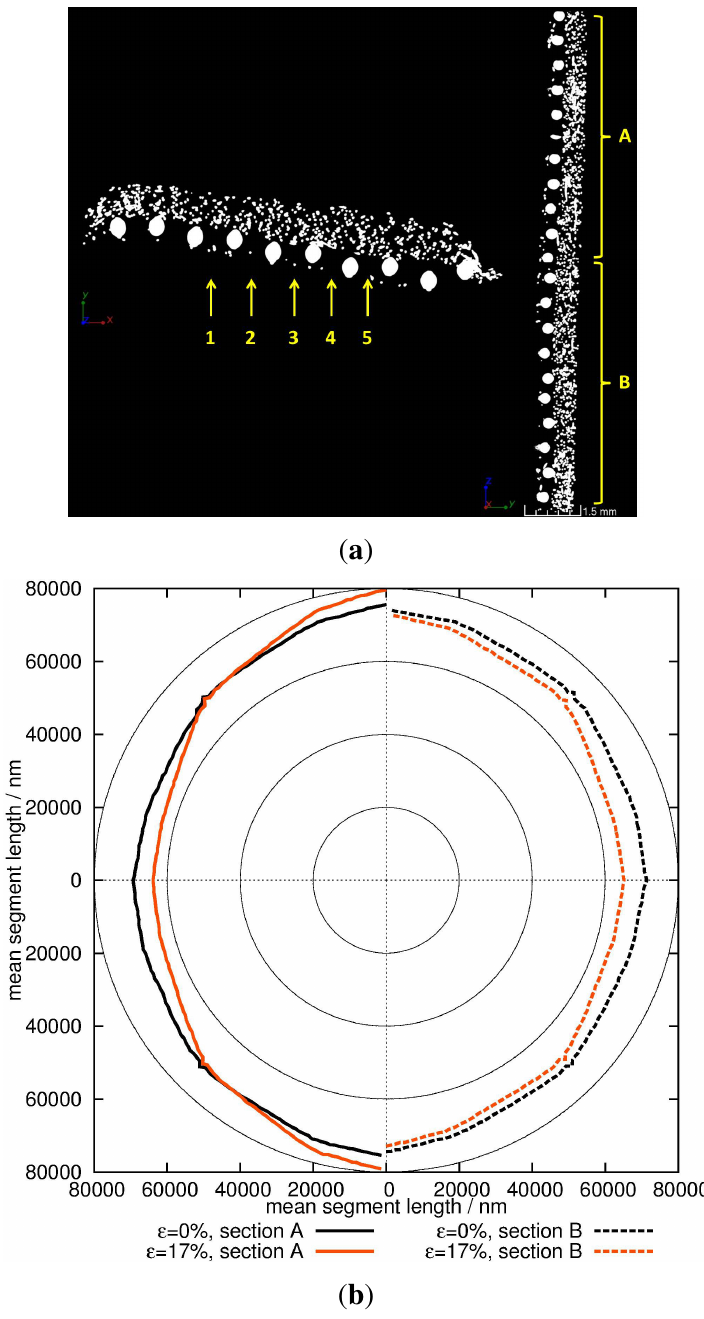
Figure 6. ( a ) extracted planes of SFF 100 at (cid:15) = 0% ; ( b ) structural ellipses of SFF 100 at (cid:15) = 0% and (cid:15) = 17%